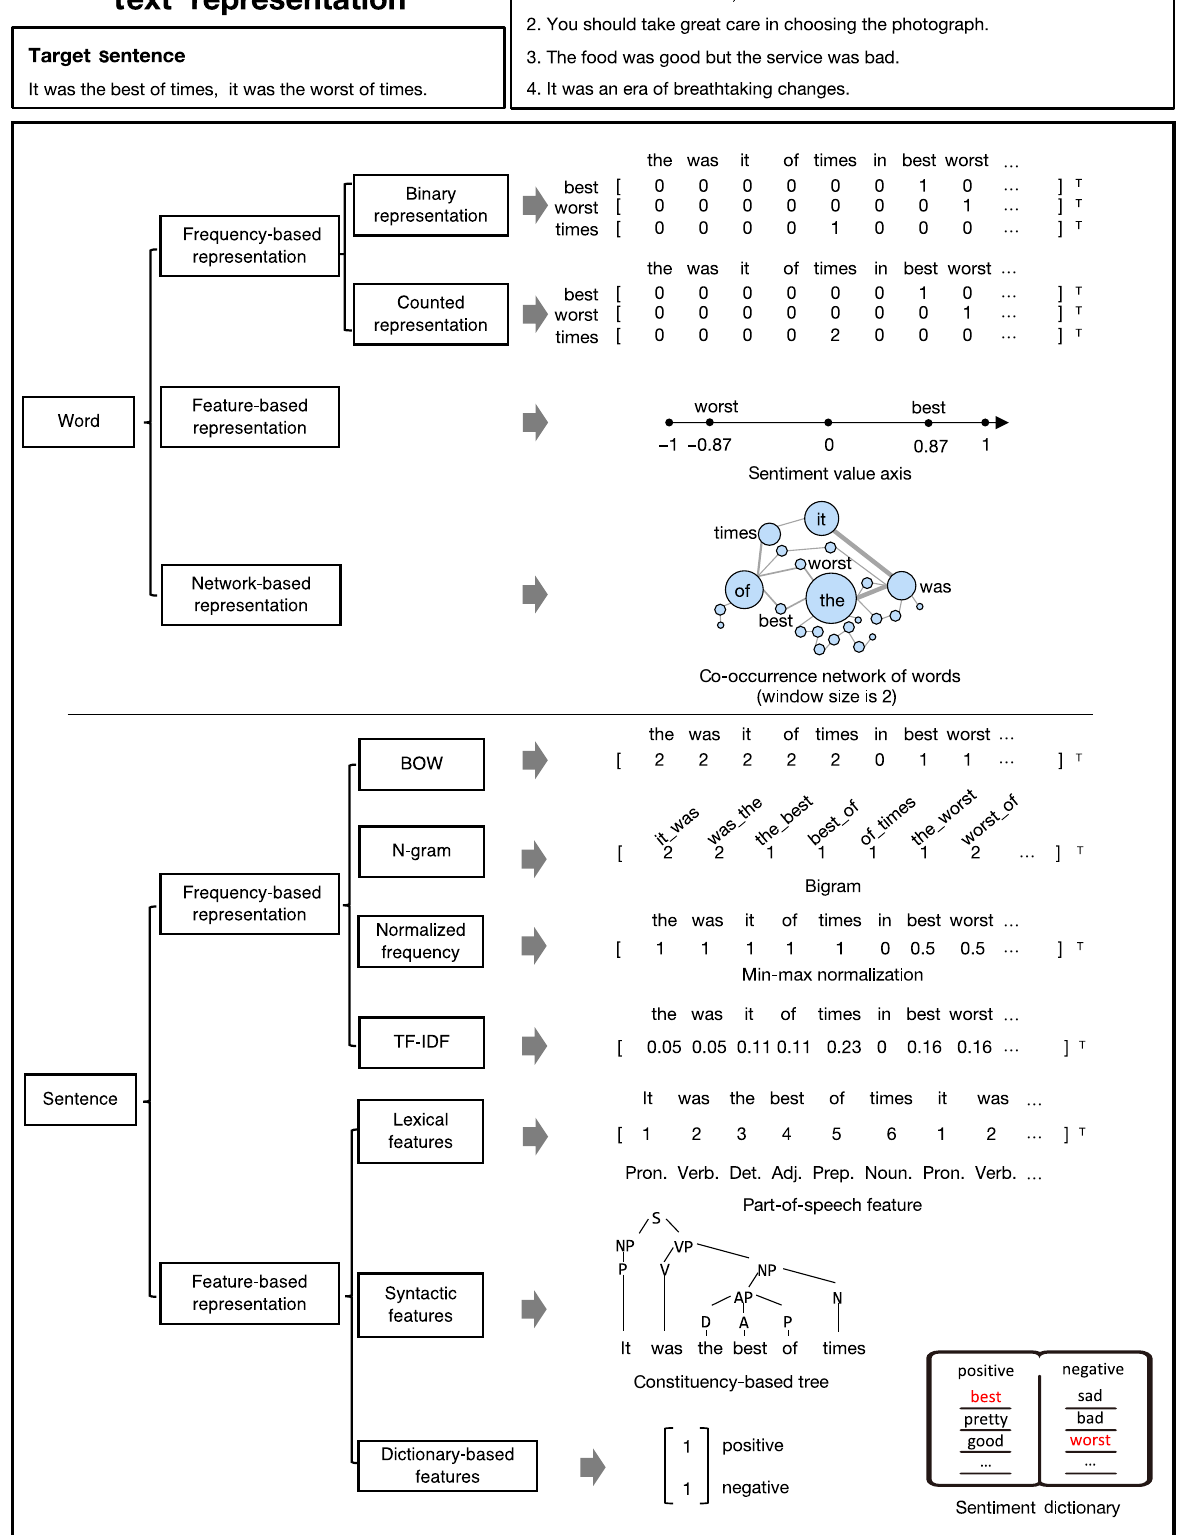
Fig. 2 An illustration of symbol-based text